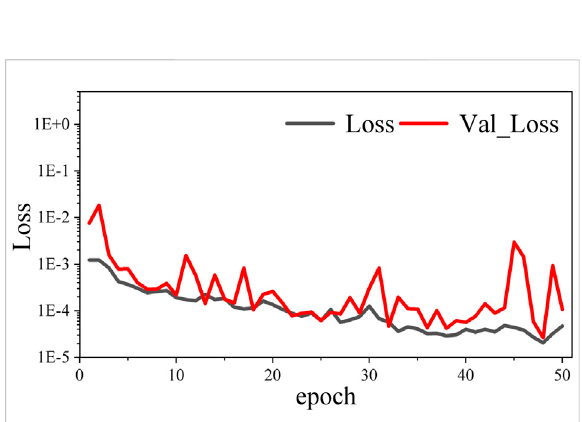
FIGURE 7 Trend of loss value of the training set ( Loss ) and loss value of the veri fi cation set ( Val_Loss ) with the mean square error indicator as the loss function in the 1 input